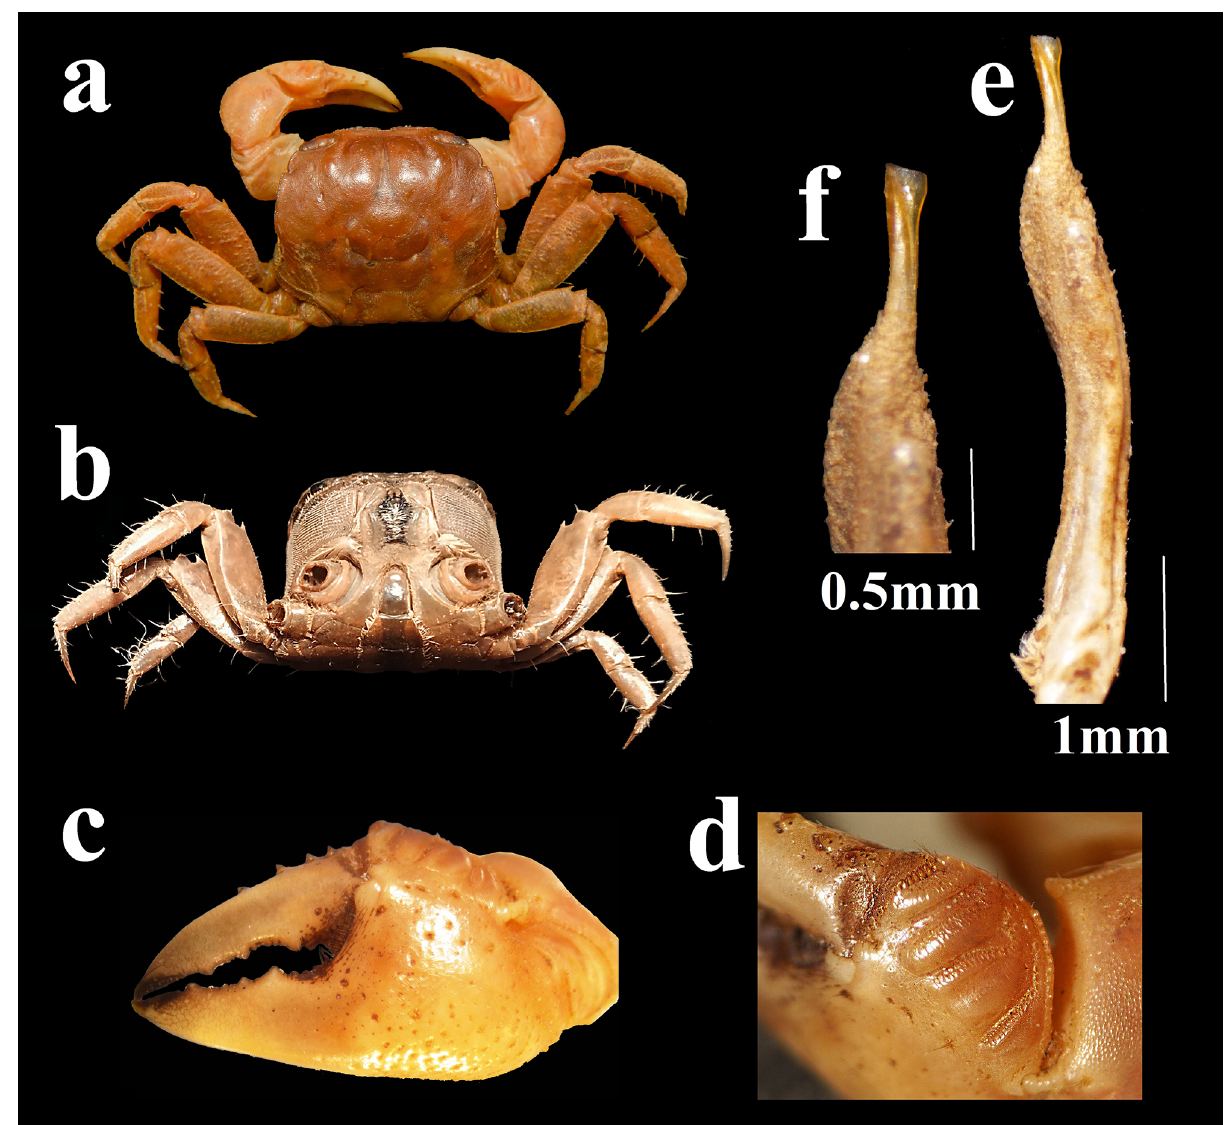
Figure 1. Sarmatium crassum Dana, 1851, male (LFSc.ZRC– 155), CL 9.6 mm; CW: 10.6 mm: a , dorsal habitus; b , ventral habitus; c , left chela, outer view; d , upper surface of palm of left chela; e , left G1, dorsal view; f , distal tip of G1, dorsal